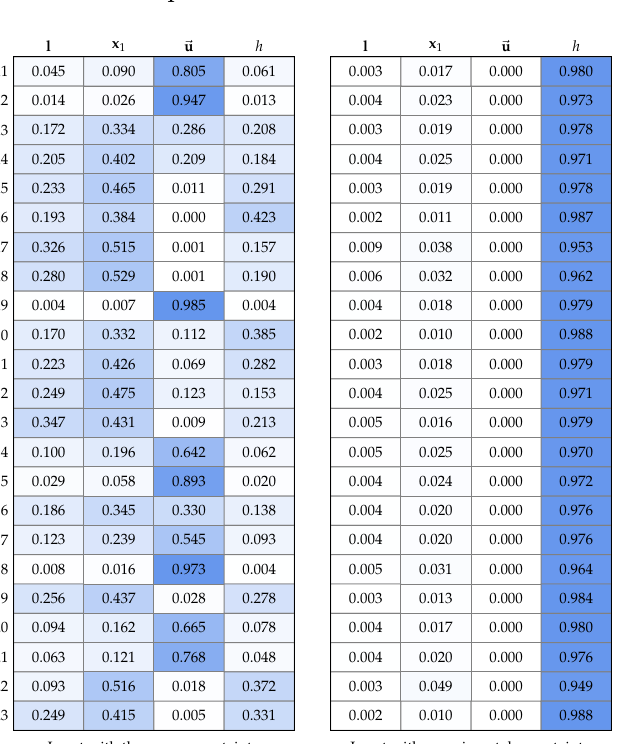
Figure 9. The relative impact of the input parameters on the computed speeds, assuming that ( left ) all input variables were independent and had the same uncertainty or ( right ) had the uncertainty that was estimated for the experiments: l represents the vanishing line; x 1 is the reference corner of the ROI; (cid:126) u is the direction of the vessel; and h is the camera height. Stronger shades of blue indicate greater relative